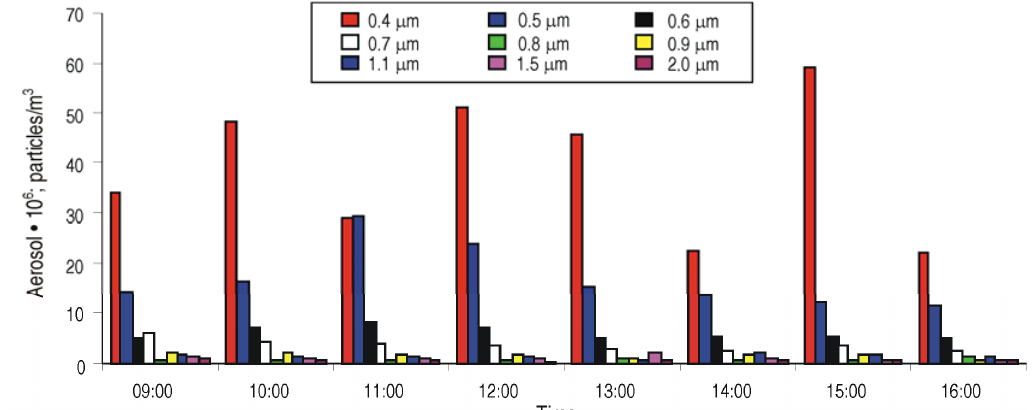
Fig. 4. Variation of the numerical concentration of aerosol particles during working